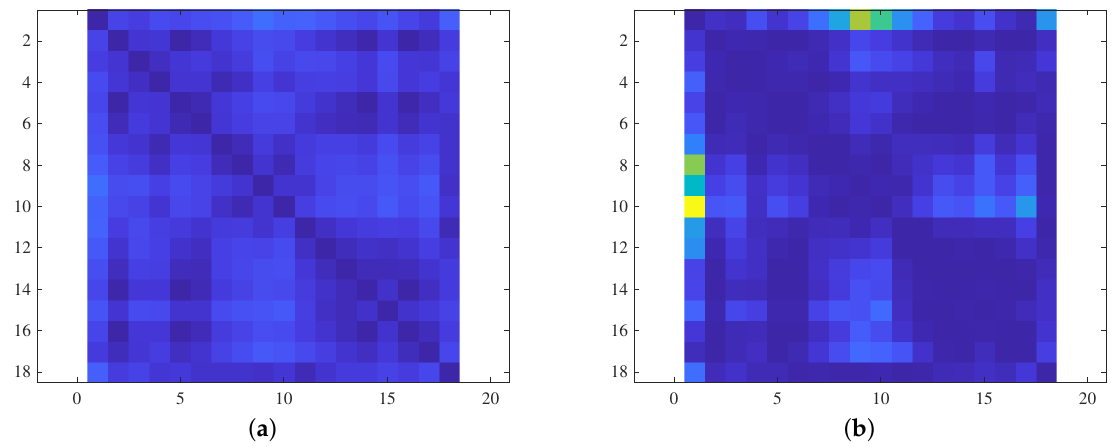
Figure 7. Cost matrices of TSP algorithms: ( a ) A Euclidean cost matrix. ( b ) A covariance cost